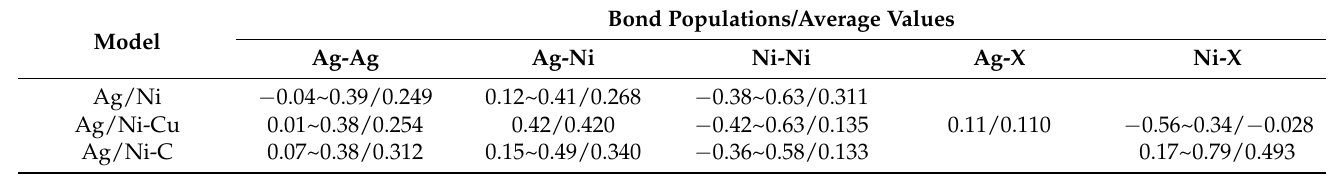
Table 5. Bond populations and average values for various types of